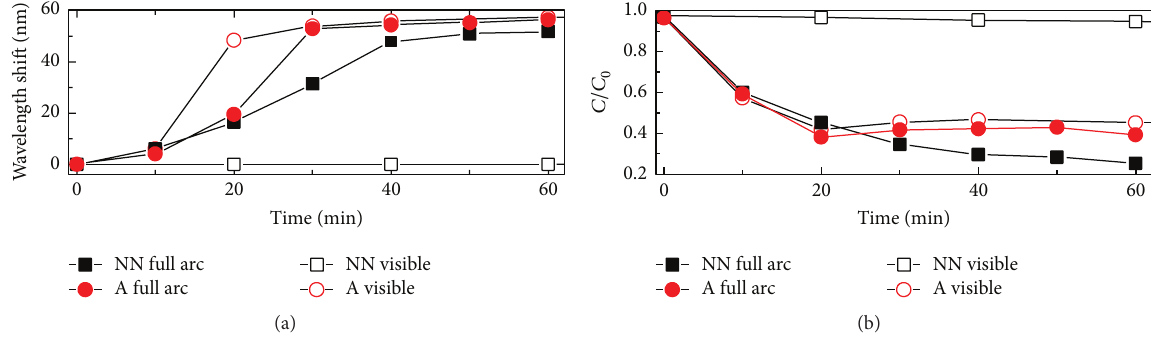
Figure 6: Variation in 𝐶/𝐶 0 (b) and wavelength shift (a) over NN and A under full arc Xe lamp irradiation (solid square and cycle). Those under visible light (empty square and cycle) were also shown for